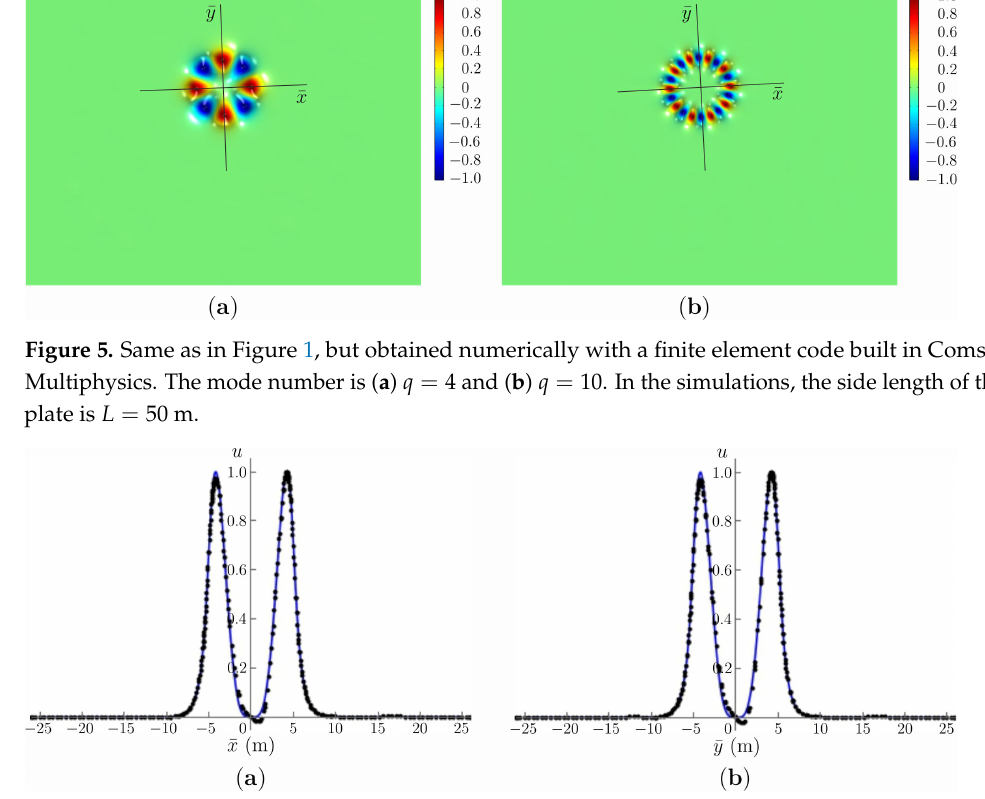
Figure 6. Displacements in the plate for q = 4, determined along the direction ¯ x cutting two maxima ( a ) and along the perpendicular direction ¯ y ( b ). The solid lines represent the analytical results, while the dots are the numerical outcomes provided by Comsol